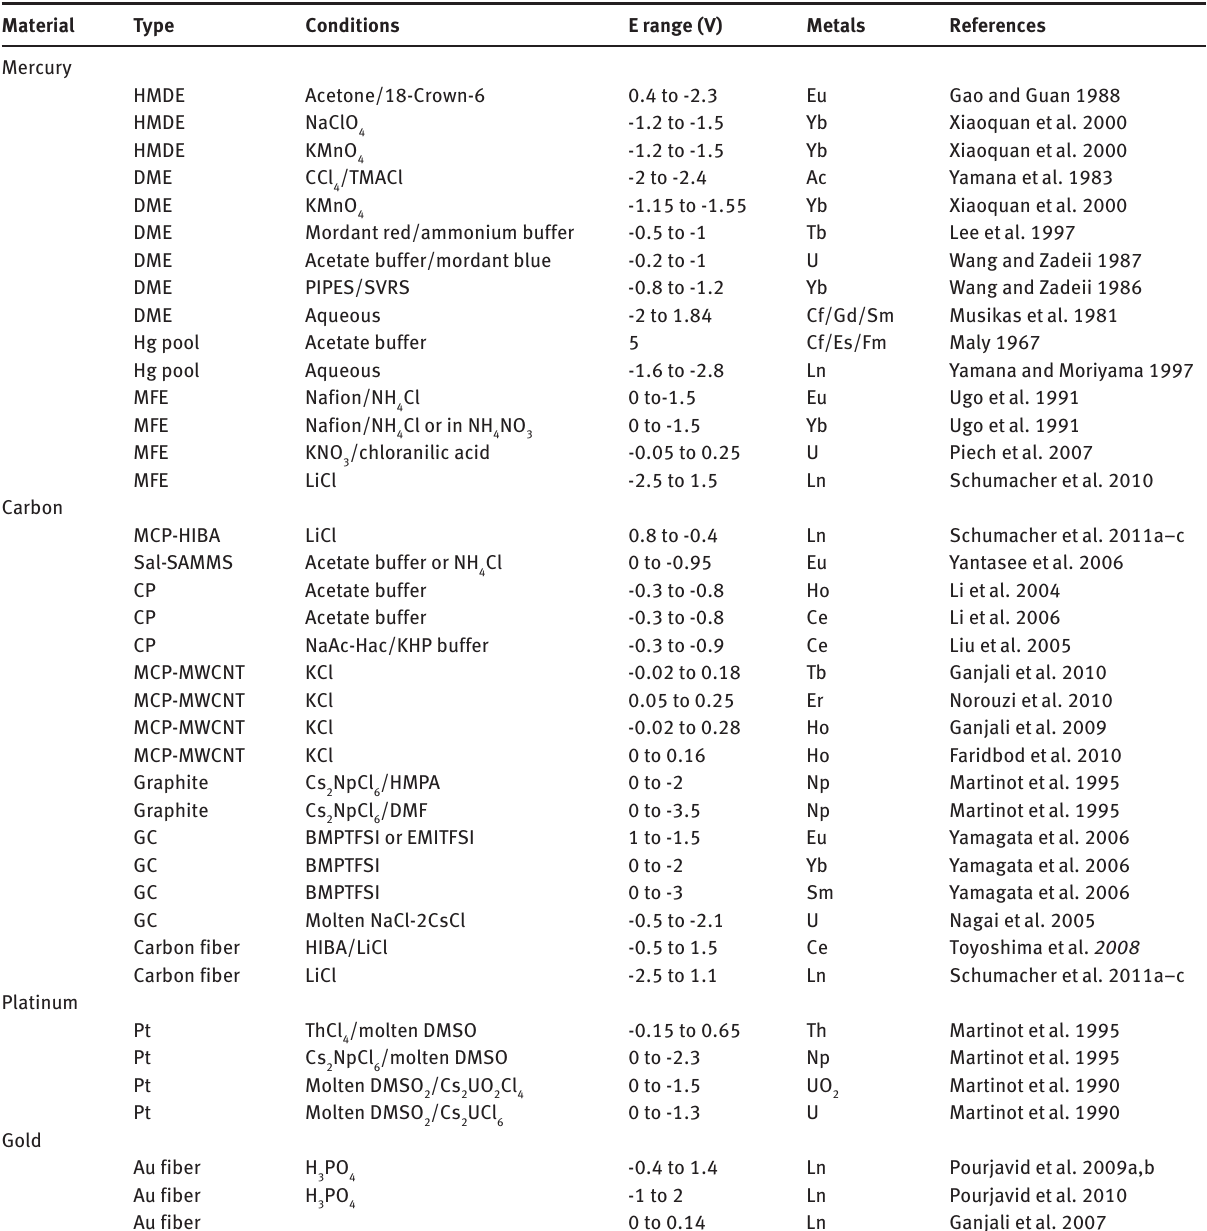
Table 2 Summary of electrode potential